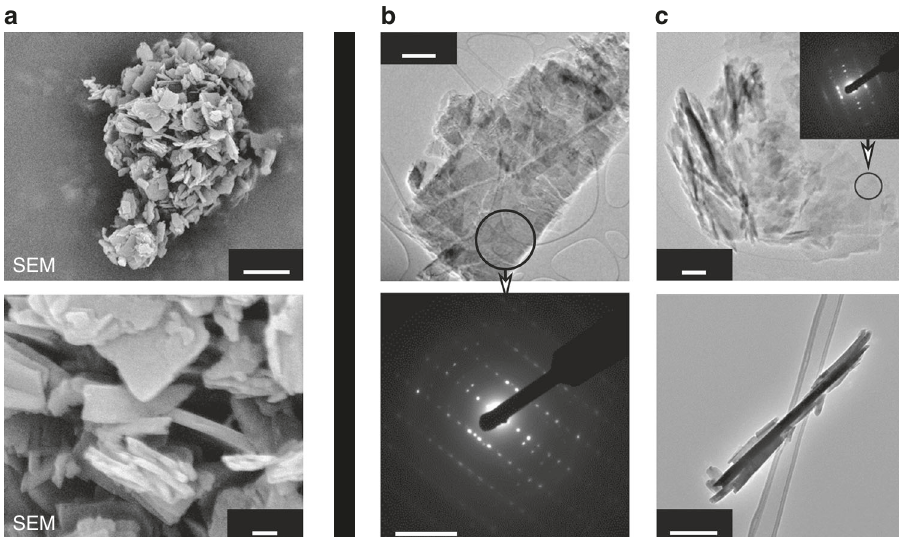
Fig. 3 Characterizations by electron microscopy techniques. a Typical SEM images obtained by means of backscattered electrons of desolvated Mg(Li 2 )- p - DHT particles showing agglomerations of thin platelets. Scale bar represents 1 µ m (up) and 100 nm (down), respectively. b TEM image of a large platelet together with the corresponding SAED pattern, recorded from the circled zone, revealing an orthogonal 2D cell of ~3.3 × 7.8 Å. Additional signal comes from slightly disoriented exfoliated layers. Scale bar represents 0.5 µ m (up) and 5 nm − 1 (down), respectively. c Additional view of the thin, partly exfoliated, creased or rolled particles, together with the same selected-area electron diffraction (SAED) pattern recorded on fl at particles. Bottom: micron- long rolled particles forming a 40-nm tube. Scale bar represents 0.2 µ m